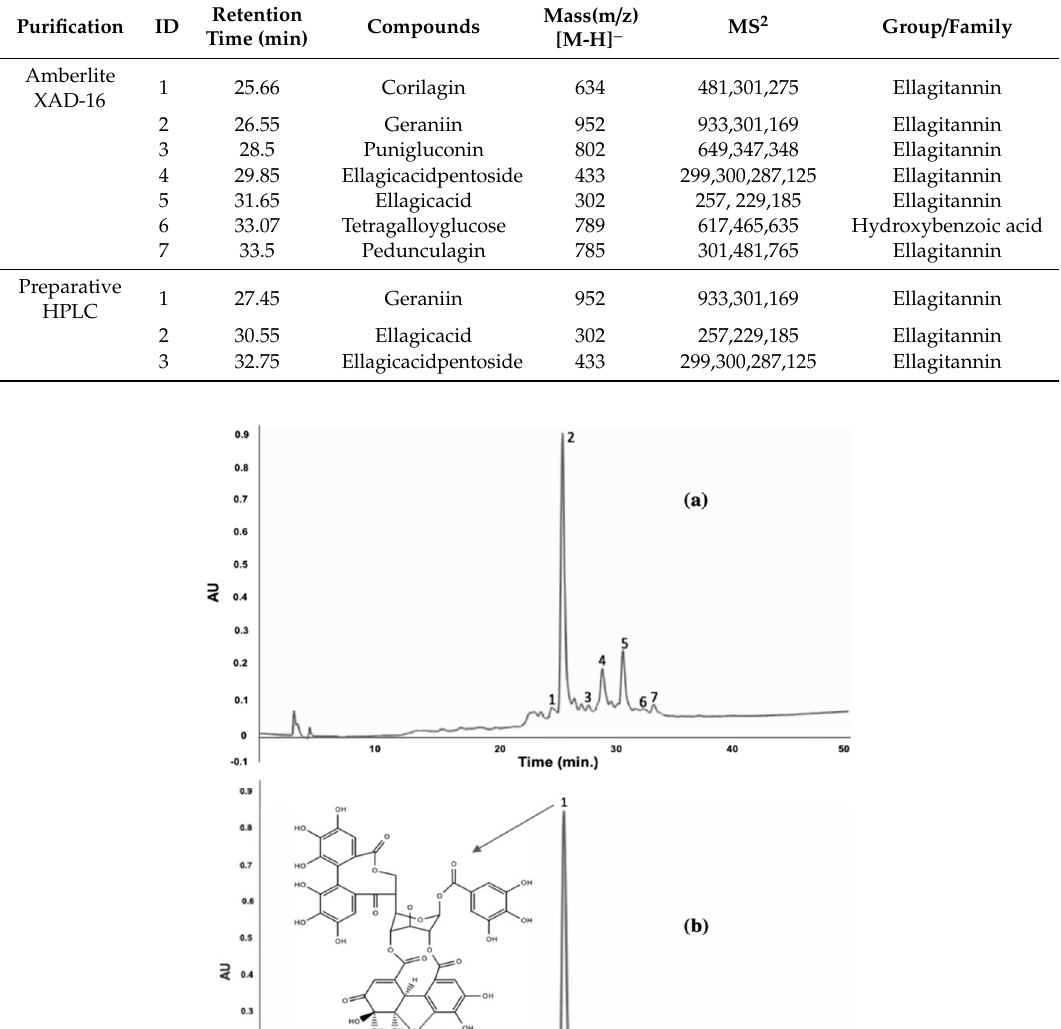
Table 2. Compounds identified by HPLC / ESI / MS.